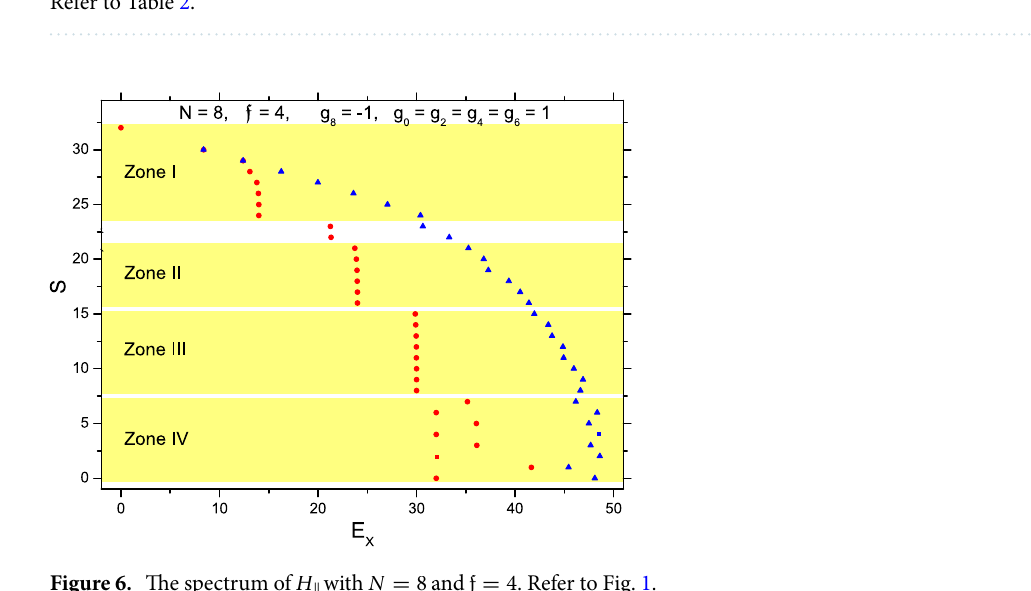
Figure 6. The spectrum of H (cid:31) with N = 8 and f = 4 . Refer to Fig.